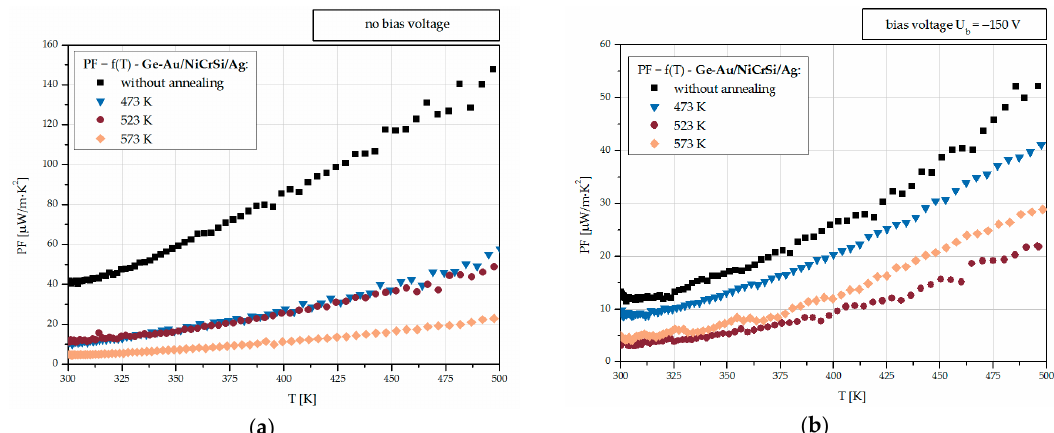
Figure 8. The power factor PF as a function of the structure’s temperature T before and after annealing: ( a ) Ge–Au/NiCrSi/Ag test structures deposited in the sputtering process without external bias voltage; ( b ) Ge–Au/NiCrSi/Ag test structures deposited in the sputtering process with external bias voltage.